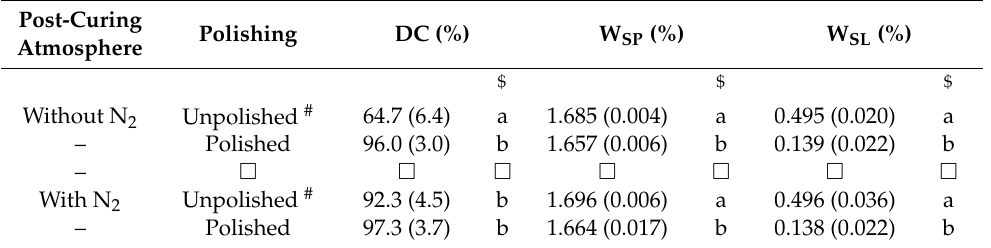
Figure 5. The broken ratio of specimens broken during the flexural strength and modulus test. The asterisk ( * ) indicates a statistically significant difference between the unpolished and polished groups when compared by the Chi-squared test. It was noted that the polished group showed a lower broken ratio than the unpolished group in each subgroup. # : data of the unpolished subgroups were quoted from the previous study [19]. Figure 6. The representative plots of mass changes (%) against time during the water immersion and the second drying procedures. w/o N 2 : stroboscopic post-curing in the air atmosphere. Post- curing w/ N 2 : stroboscopic post-curing at a nitrogen gas atmosphere. It was noted that saturation was achieved 14 days after water immersion and drying was completed 20 days after drying began in all groups. # : data of unpolished subgroups were quoted from the previous study [19].